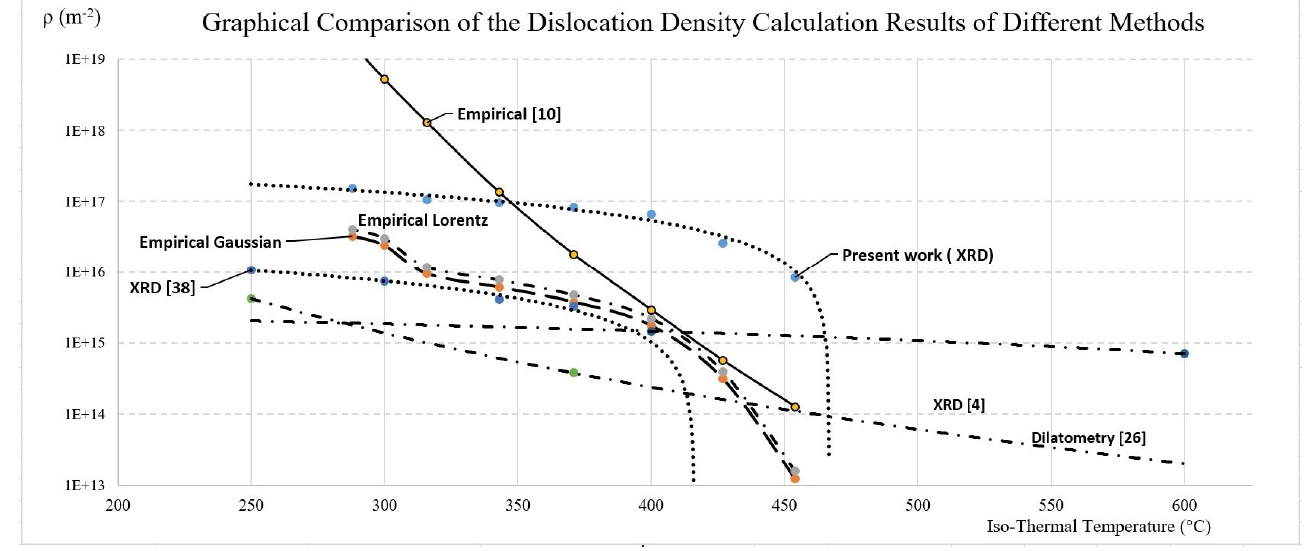
Figure 3. Graphical comparison of the dislocation calculations using different methods.